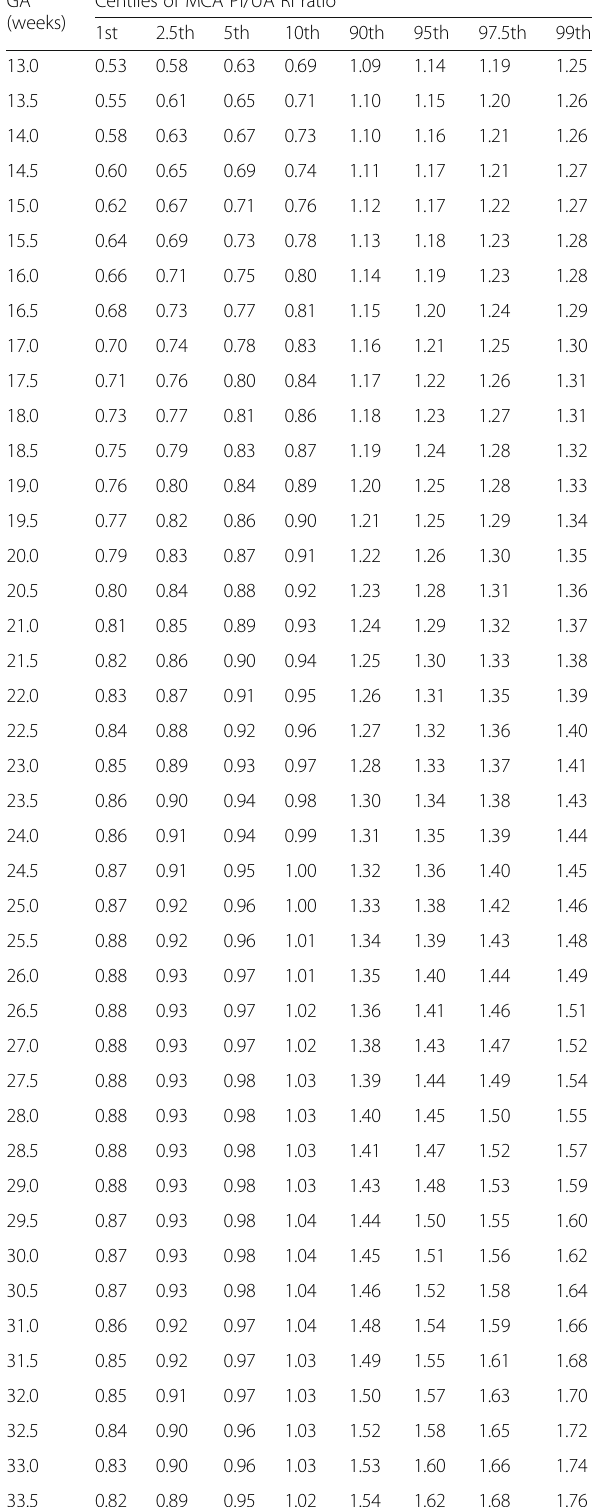
Table 4 Gestational age-defined reference ranges for MCA RI/ UA RI ratio GA Centiles of MCA PI/UA RI ratio (weeks)